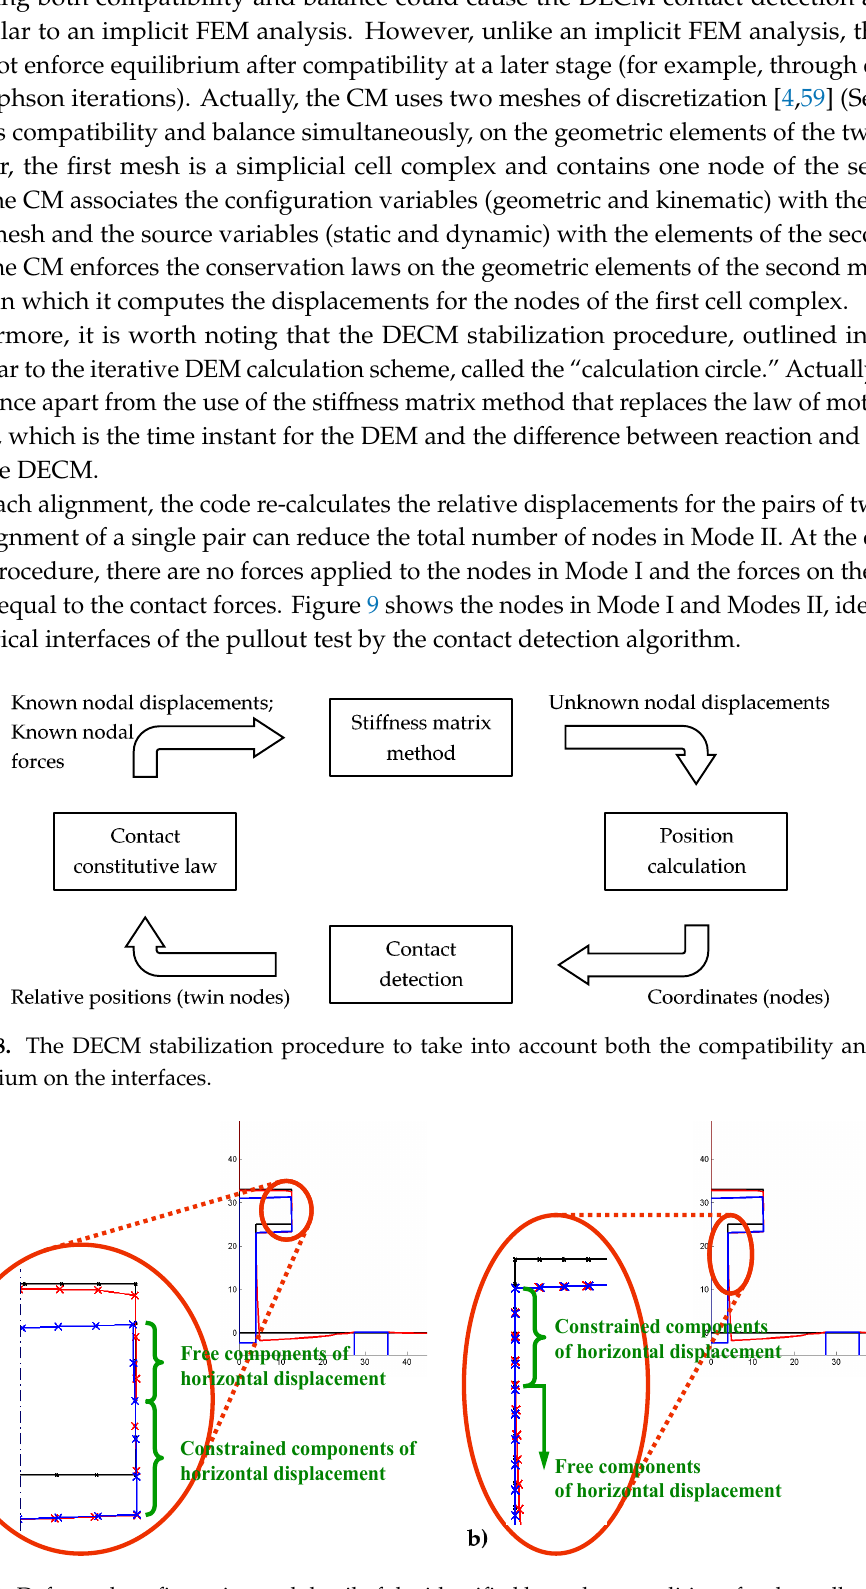
Figure 9. Deformed configuration and detail of the identified boundary conditions for the pullout test: ( a ) On the thickness of the disc and ( b ) on the rod.